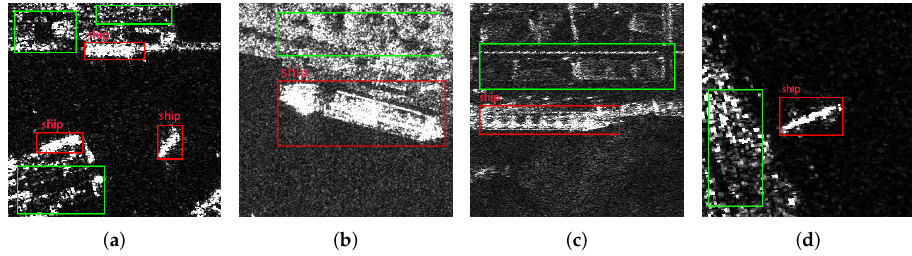
Figure 3. Objects with different densities in the SAR images. The difference in densities comes from the difference in structures. The red boxes in the figure mark the ships while the green boxes mark the areas. The densities of land are significantly different from those of the ships. ( a ) Example 1 of density difference between ships and land. ( b ) Example 2 of density difference between ships and land. ( c ) Example 3 of density difference between ships and land. ( d ) Example 4 of density difference between ships and